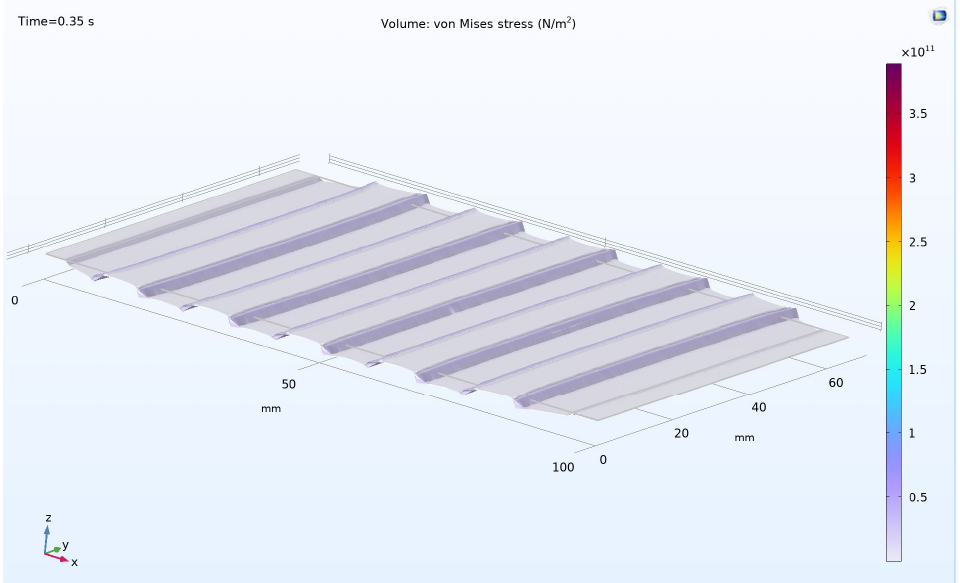
Figure 9. Von Mises stress (Pa) and deformation simulation on COMSOL ® .